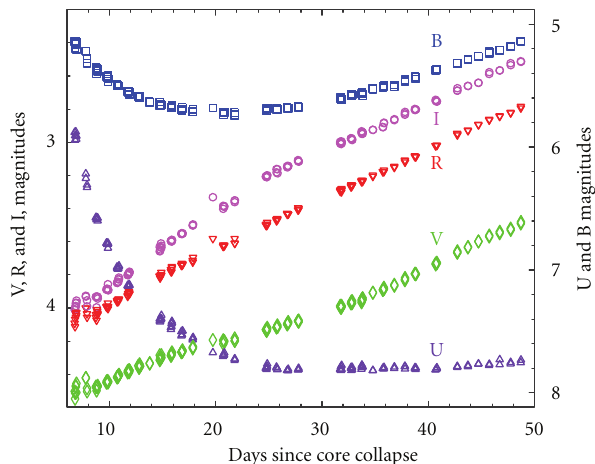
Figure 6: The U, B, V, R, and I points from the CTIO 0.41-m from days 6 to 50 (see Section 2).